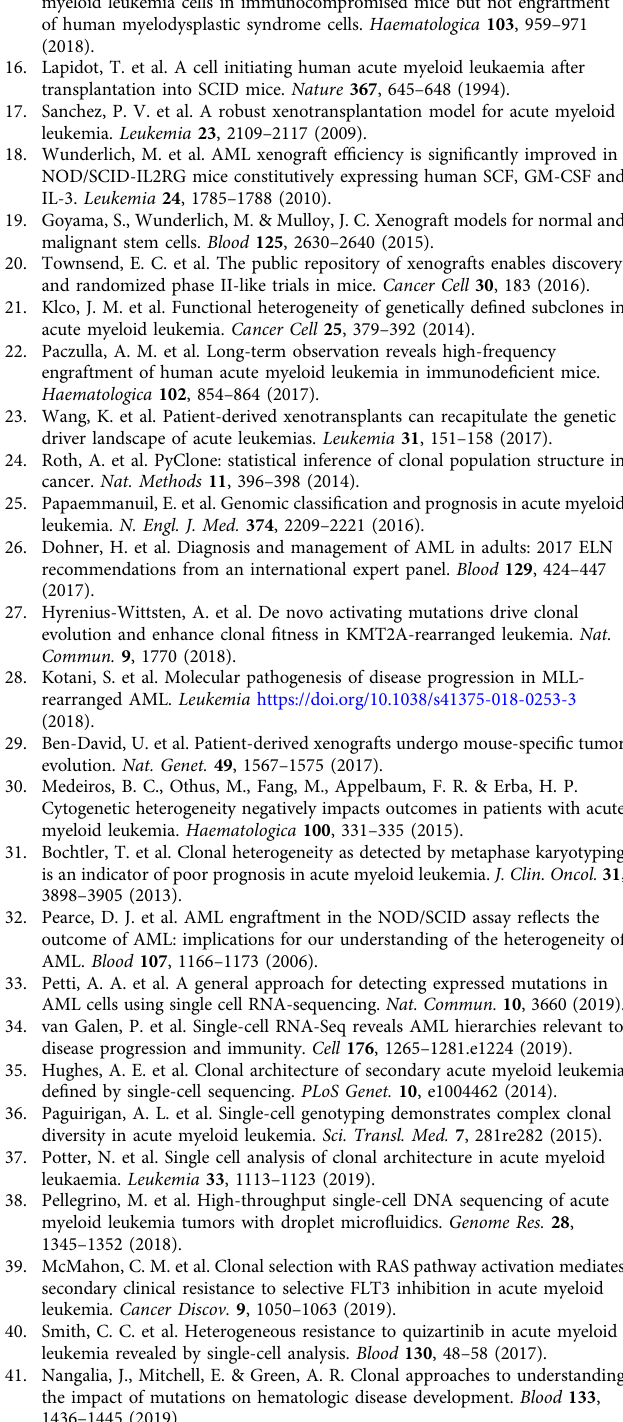
Fig. 4 Clonal competition in AML xenografts unmasks rare clones and correlates with genetic risk. Recurrent genetic alternations of all AML cases and changes in allele frequencies from patient samples to xenografts. Dark green: mutation with increased frequency that was undetectable at diagnosis. Light green: mutation with increased frequency. Yellow: mutation with maintained frequency. Light purple: mutation with reduced frequency. Dark purple: mutation with reduced frequency, revealing a parental clone that was undetectable at diagnosis. Gray: mutation in nonengrafting sample. CNA copy number alteration. Relapse samples are denoted by “ r ” after the case number. Risk category classi fi cation based on the ELN 2017 guidelines. Light blue: favorable. Medium blue: intermediate. Dark blue: adverse. The dual coloring for AML-34 re fl ects the classi fi cation as intermediate based on information from the diagnostic sample alone and the classi fi cation as adverse when incorporating information derived